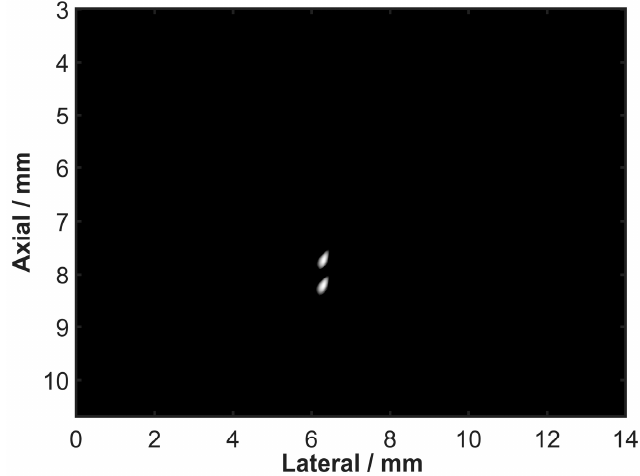
Figure 11. The detected wire phantom image. The full width at half maximum (FWHM) of the envelope signals of the wire was taken as a characterization parameter for system lateral and axial imaging resolution, as shown in Figure 12 below. According to evaluation of the line spread function based on Rayleigh Criterion [26,27], the lateral and axial resolutions of the system are 140 µ m and 168 µ m, respectively.